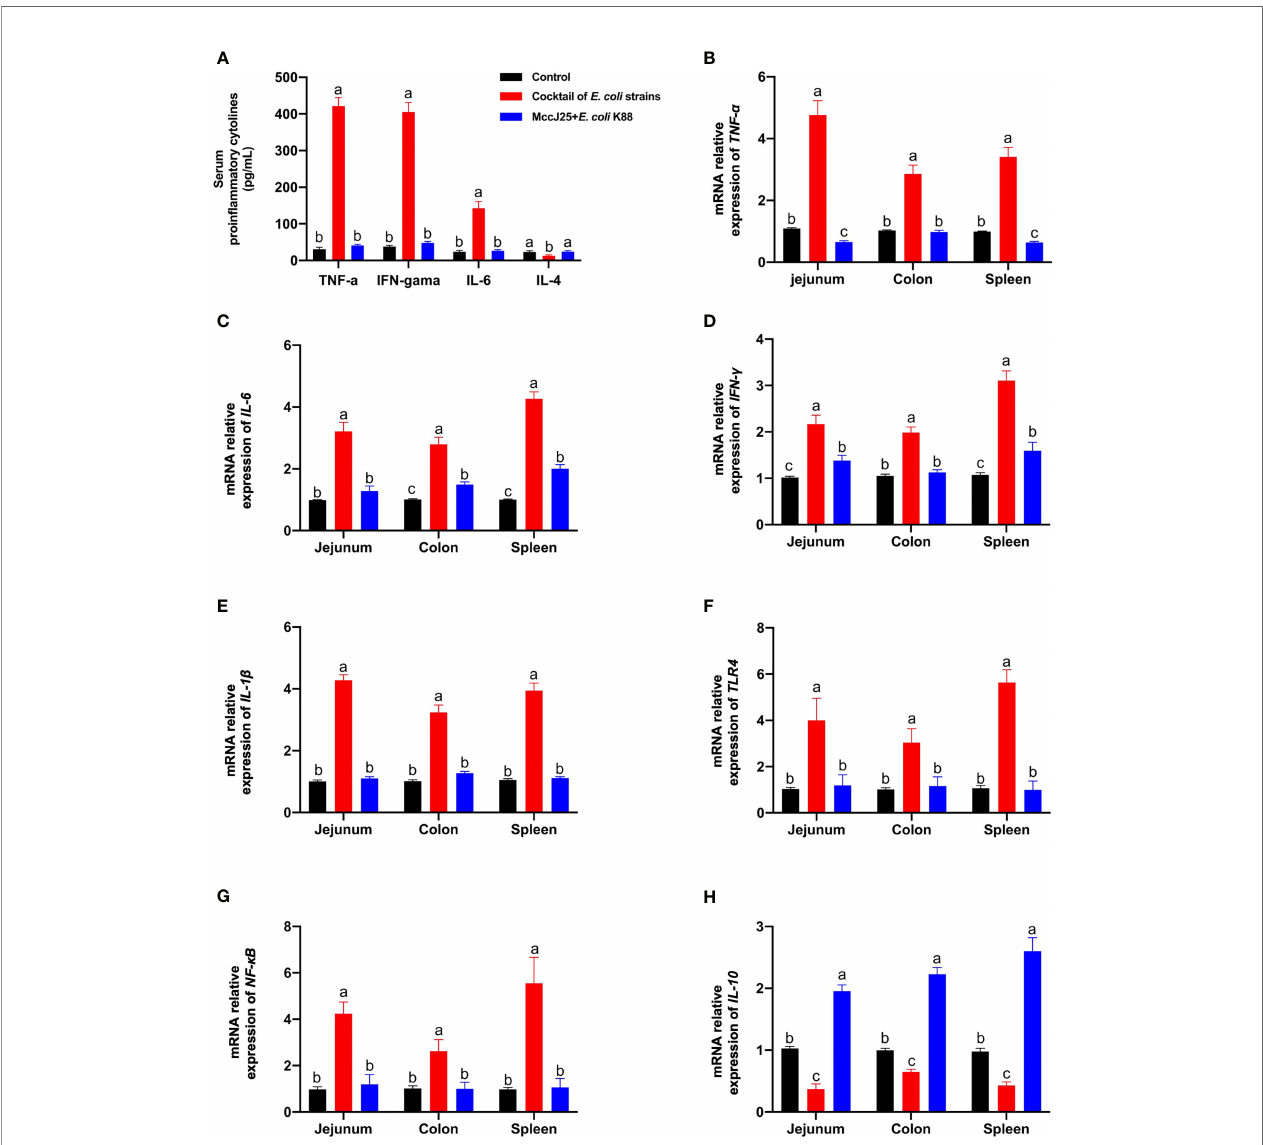
FIGURE 12 | Protective ability of MccJ25 on the in fl ammatory responses. (A) Serum of critical proin fl ammatory cytokines TNF- a , IFN- g , IL-6, and IL-4. mRNA expression of proin fl ammatory markers (B) TNF- a , (C) IL-6 , (D) IFN- g , (E) IL-1 b , (F) IL-10 , (G) TLR4 , and (H) NF- k B . Infected mice in the MccJ25 group received 200 m L MccJ25 once/day for 3 d by oral gavage. Mice in the control and infected group were orally administrated with 200 m L sterile PBS. Equal volume PBS containing 10 8 CFU/mL clinically source cocktail of MDR E coli strains was challenged to infect the mice. Data are given as the mean ± standard error of mean (n = 6). Differences were analyzed using a one-way ANOVA followed by a Tukey ’ s multiple range test. Different superscript lowercase letters within each group indicate signi fi cant differences ( P <